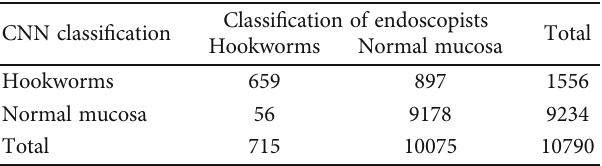
Table 3: Classi fi cation of images predicted by the CNN technology.